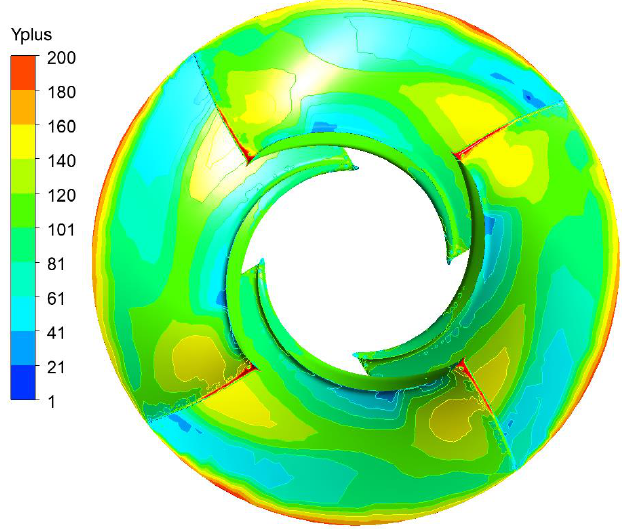
Figure 4. The distribution of the Y+ parameter on the blade’s surfaces.